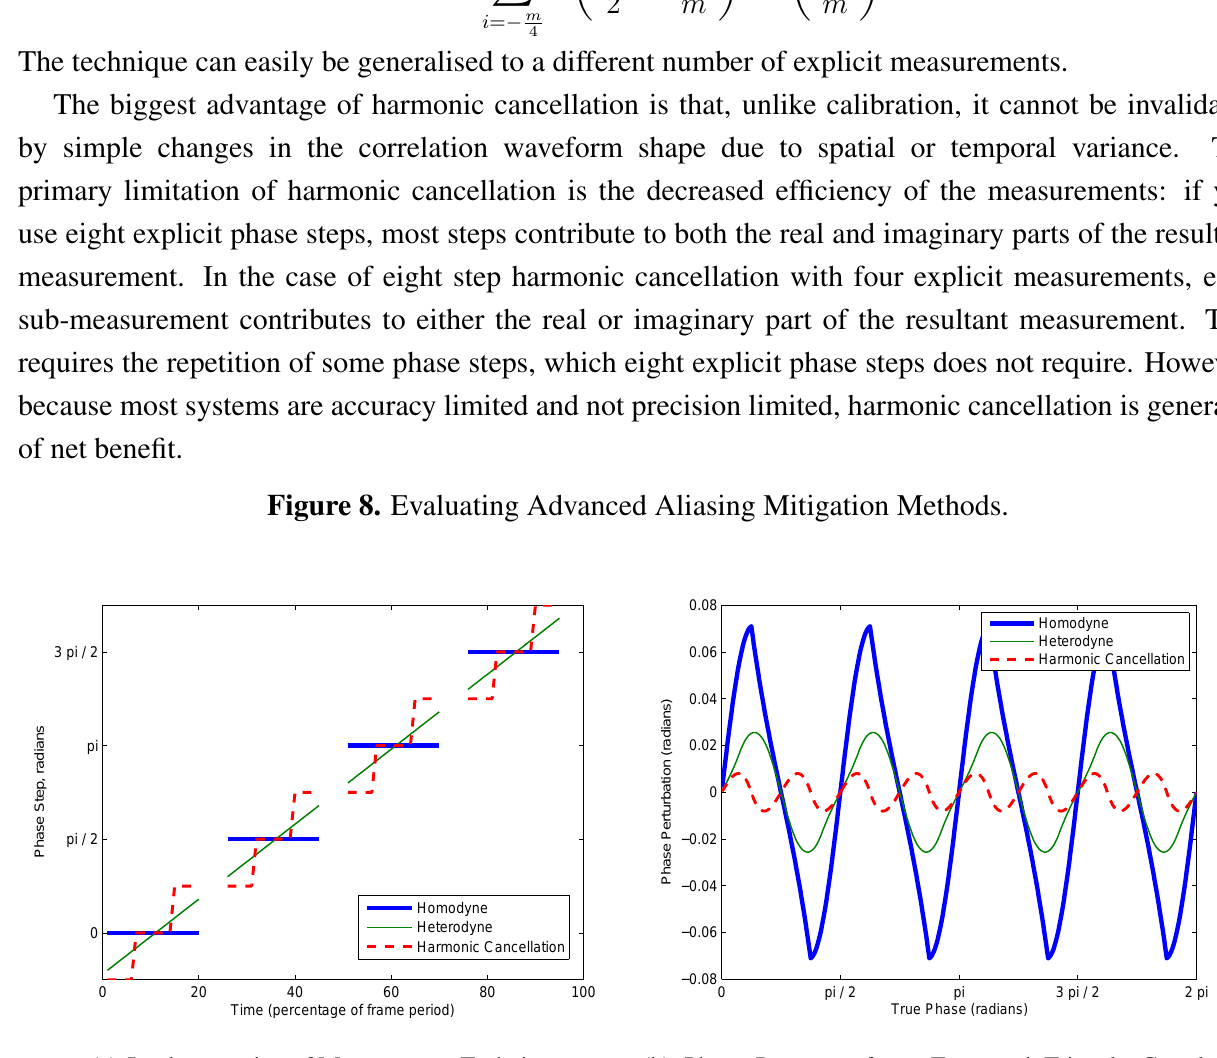
(b) Phase Response for a Truncated Triangle Correlation